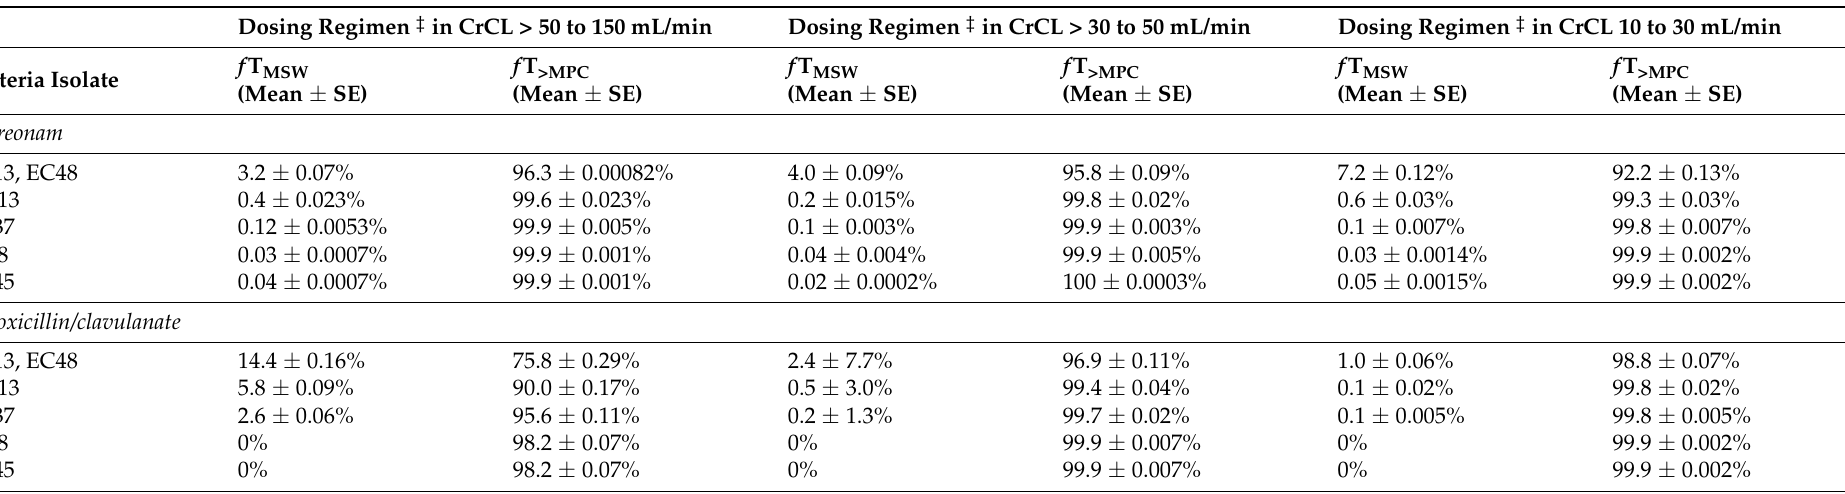
Table 4. Pharmacodynamic parameters f T MSW and f T >MPC computed based on MIC and MPC of aztreonam and amoxicillin/clavulanate as combination therapy in the plasma against E. coli and K. pneumoniae isolates harboring NDM and serine- β -lactamases. Dosing Regimen ‡ in CrCL > 50 to 150 mL/min Dosing Regimen ‡ in CrCL > 30 to 50 mL/min Dosing Regimen ‡ in CrCL 10 to 30